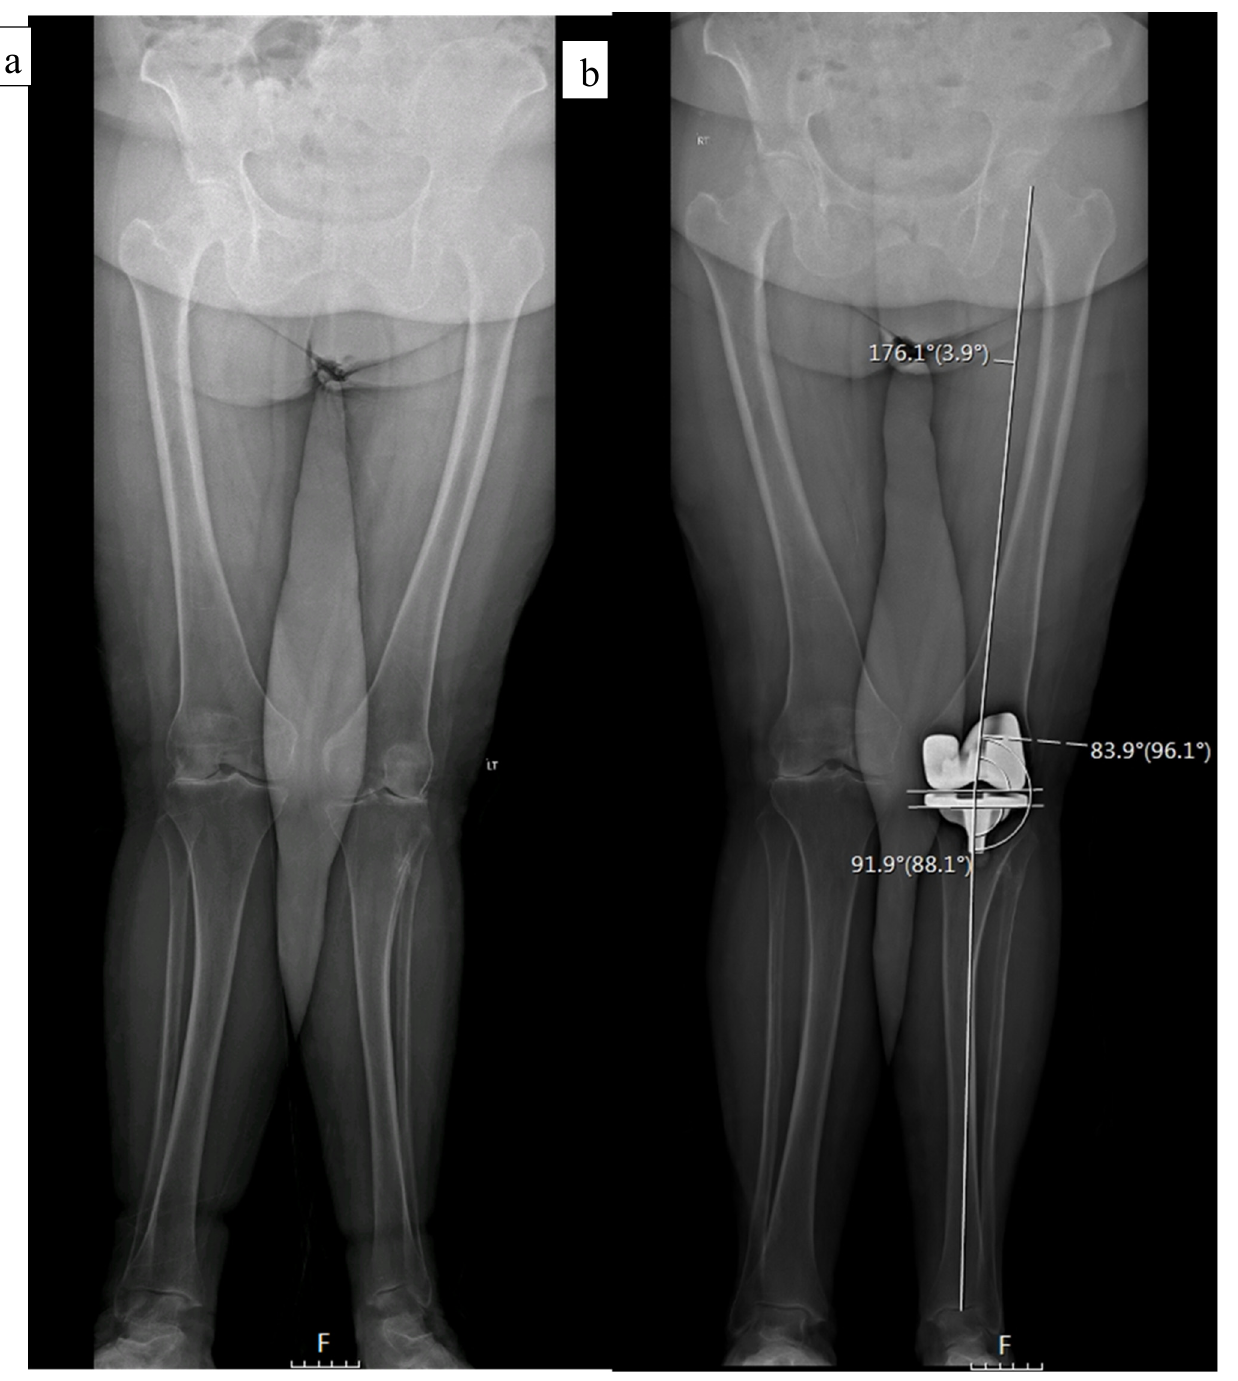
Figure 1. A 76-year-old female with a preoperative valgus alignment ( a ). Postoperative radiographic analysis shows a MPTA of 88.1°, LDFA of 83.9°, and HKA of 3.9° ( b ).